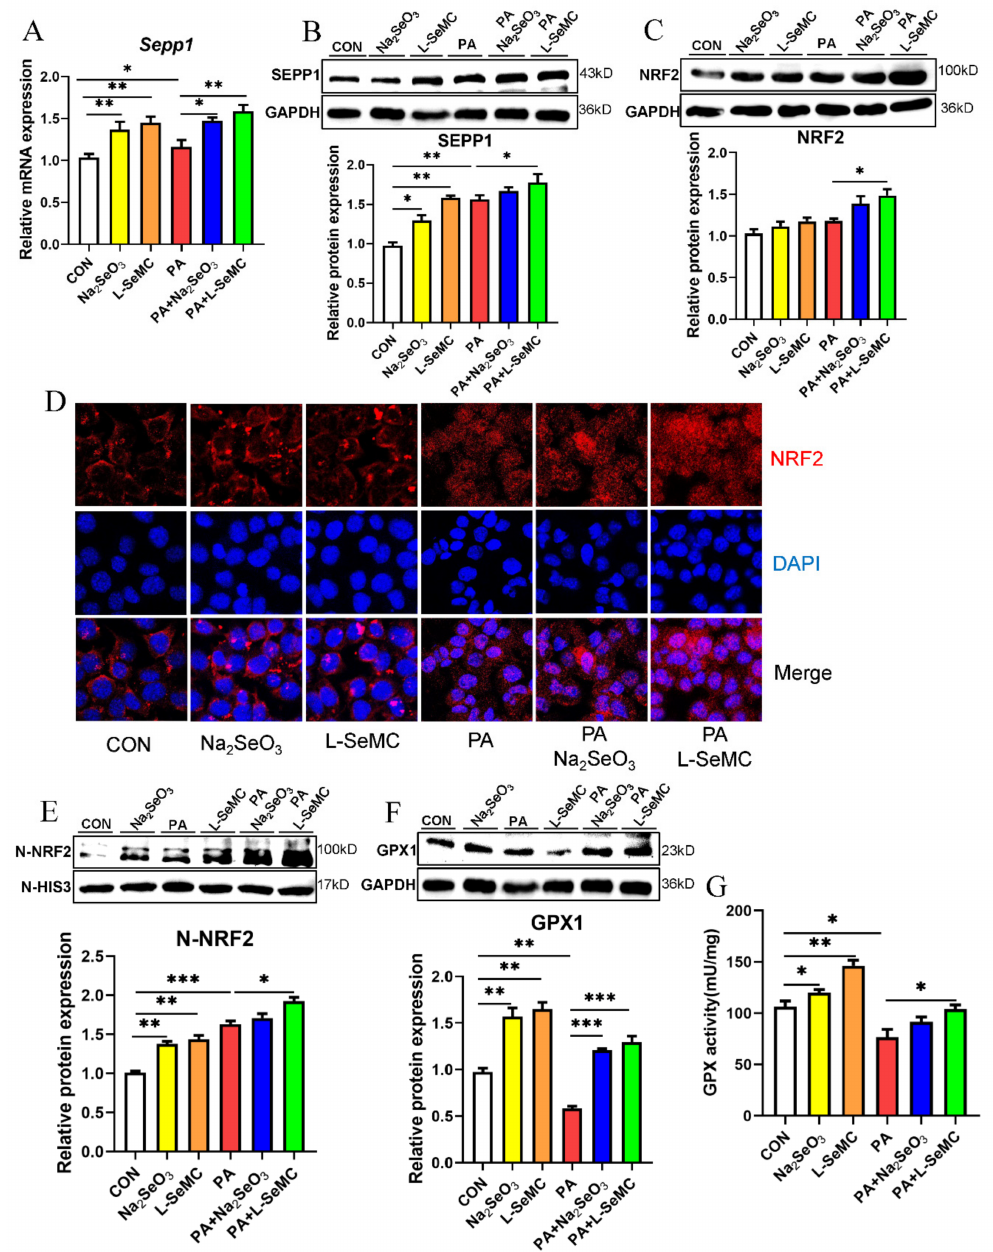
Figure 5. Effects of Na 2 SeO 3 and L-SeMC on the Keap1/Nrf2 pathway in PA-induced AML-12 cells. ( A ) The mRNA level of Sepp1 ( n = 3, ** p < 0.01, * p < 0.05). ( B ) The protein level of SEPP1 ( n = 3, ** p < 0.01, * p < 0.05). ( C ) The total protein level of NRF2 ( n = 3, * p < 0.05). ( D ) The accumulation of NRF2 in the nucleus was detected by immunofluorescence (400 × magnification). ( E ) The nuclear protein level of NRF2 ( n = 3, *** p < 0.001, ** p < 0.01, * p < 0.05). ( F ) The protein level of GPX1 ( n = 3, *** p < 0.001, ** p < 0.01). ( G ) The enzyme activity of GPX1 ( n = 3, ** p < 0.01, * p <